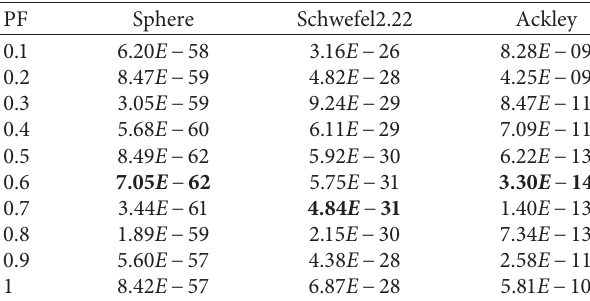
Table 2: Comparisons of the results varying